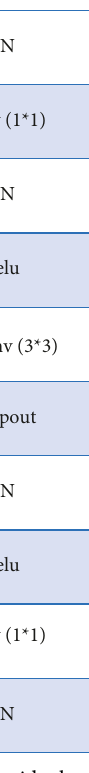
Figure 6: Improved residual unit